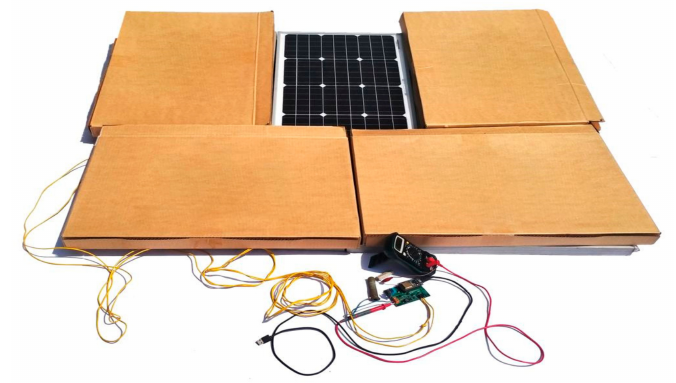
Figure 8. Four shaded PV modules and one active.